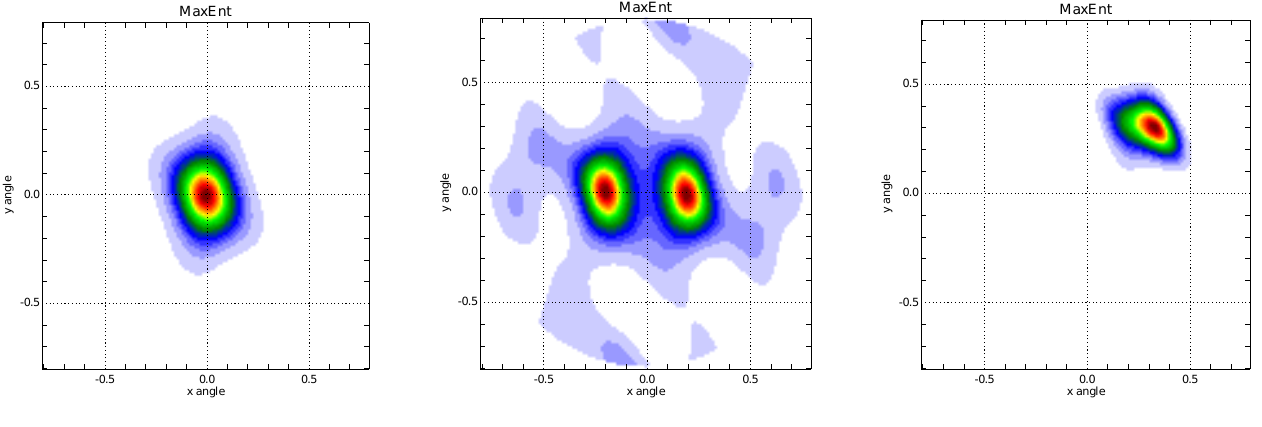
Fig. 5. Images of the model brightnesses of Fig. 1 obtained using the antenna configuration of Fig. 4 and the Maximum Entropy method.